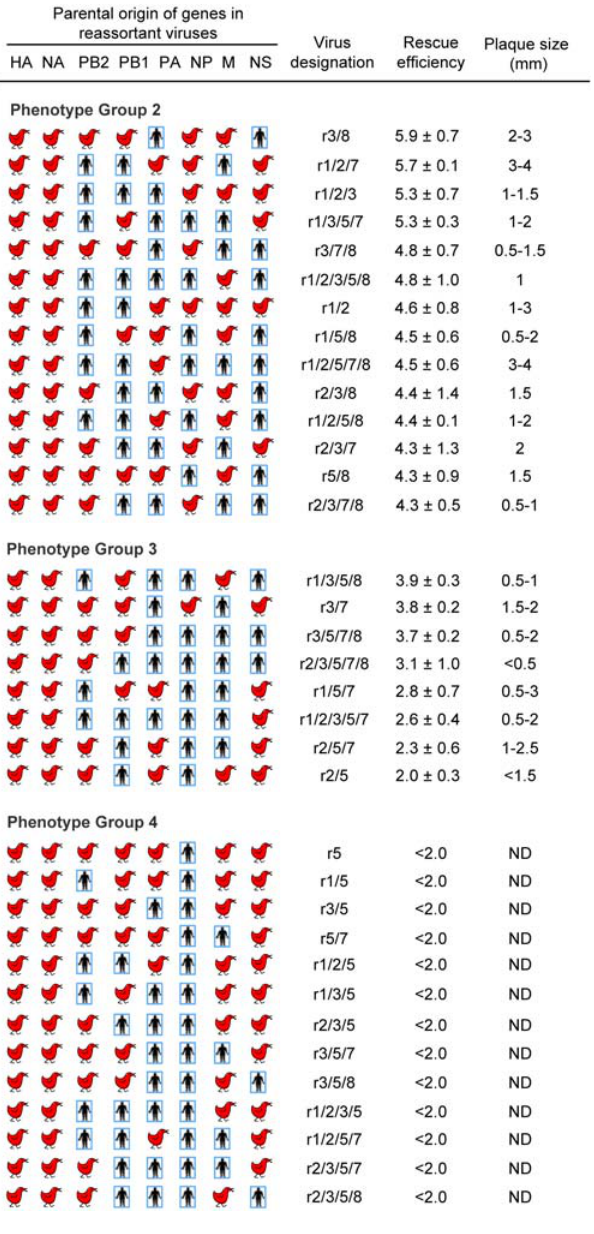
Figure 2. Characteristics of moderate to low yield avian-human reassortant viruses in cell culture. Symbols and virus nomencla- tures are the same as described in Figure 1. Rescue efficiency represents virus titer (log 10 pfu/ml) from cell cultures at 72 hours after transfection; geometric mean from 3 independent experiments. Plaque formation by reassortant viruses with , 100 pfu/ml rescue efficiency was not determined (ND).